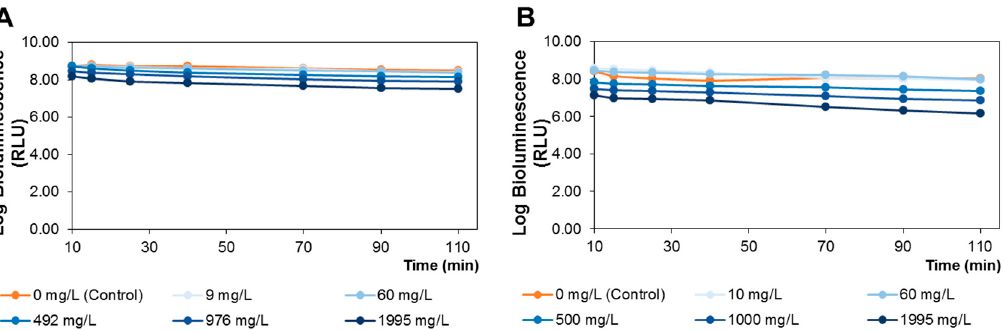
Figure 2. Bioluminescence monitoring of A. fischeri treated with elderberry polar ( A ); and lipophilic ( B ) extracts.